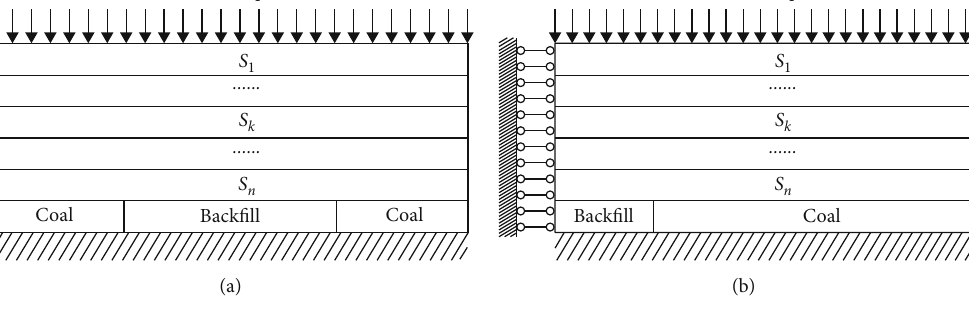
Figure 2: Continuous beam model of solid close pack mining.